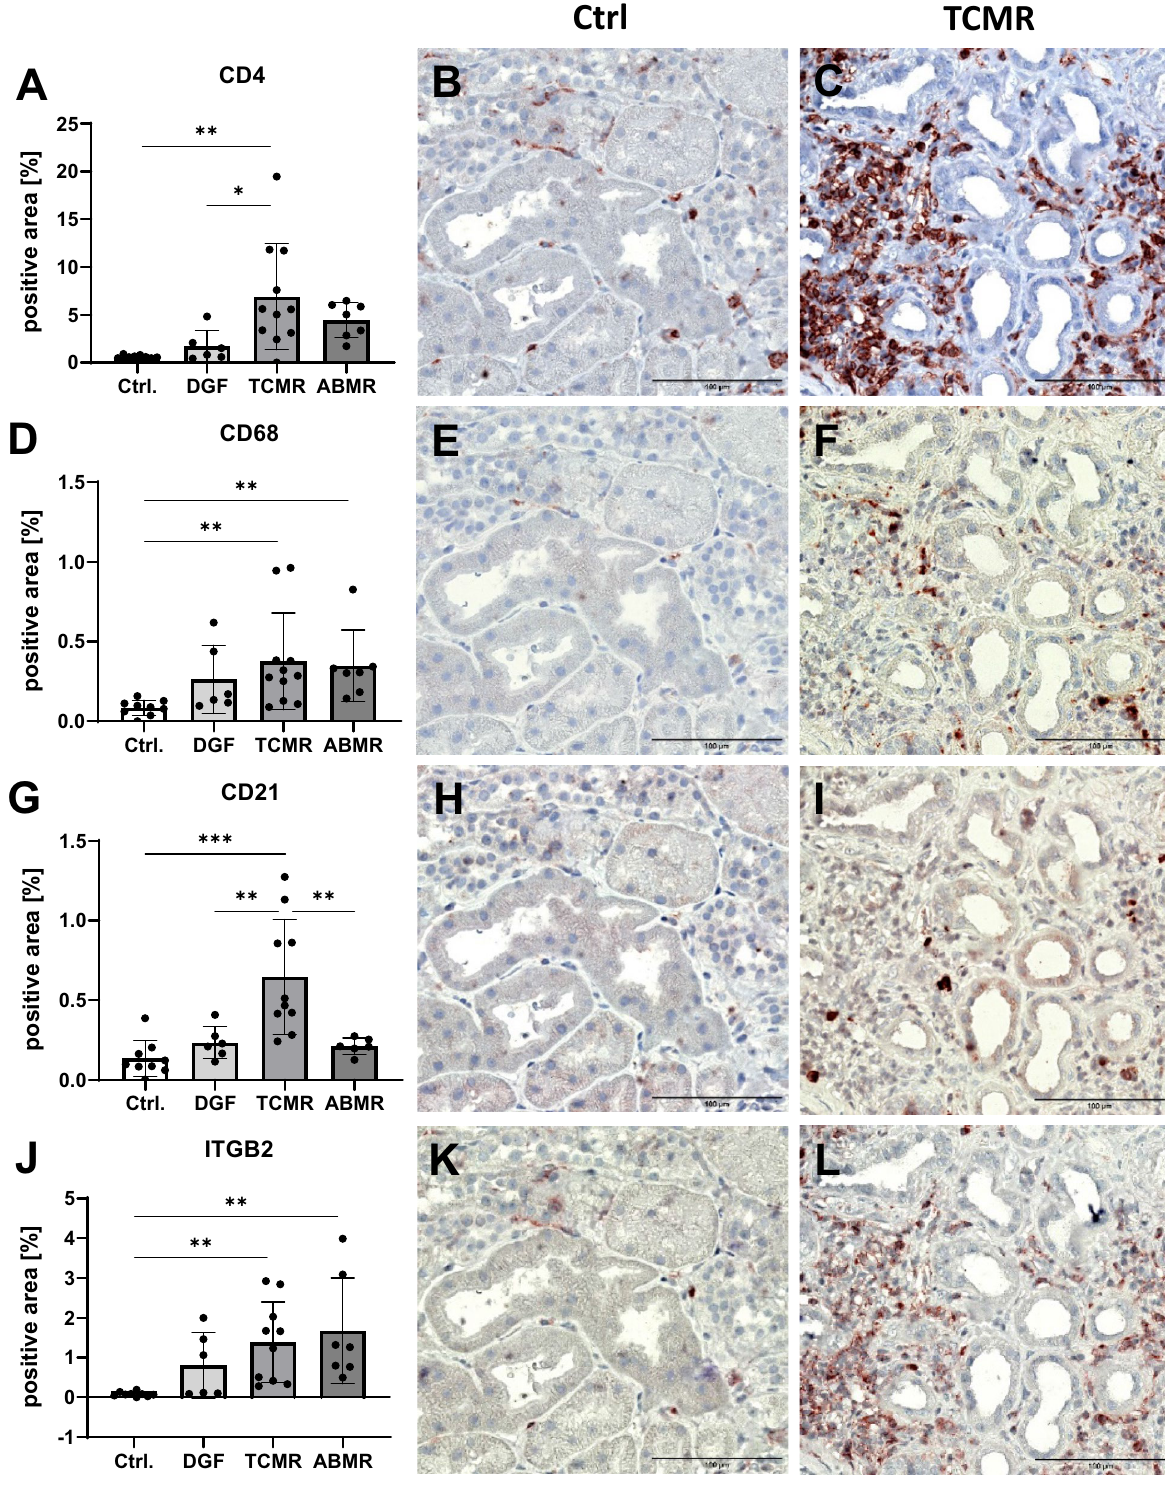
Figure 5. Deposition of immune cells in transplant biopsies. Percentage of positive stained area in follow-up biopsies of renal transplants with no rejection or dysfunction (Ctrl, n = 7), delayed graft function (DGF, n = 6), T-cell mediated rejection (TCMR, n = 8) or antibody mediated rejection (ABMR, n = 7) after immunostaining for CD4 ( A ), CD68 ( D ), CD21 ( G ) and ITGB2 ( J ); (Statistical analysis: A , G : ANOVA with Tukey’s; D , J : Kruskal–Wallis with Dunn’s;**p < 0.01; ***p < 0.001; ****p < 0.0001). Examples of biopsies with no rejection or dysfunction (Ctrl) and T-cell mediated rejection (TCMR) after immunostaining for CD4 ( B , C ), CD68 ( E , F ), CD21 ( H , I ) and ITGB2 ( K , L